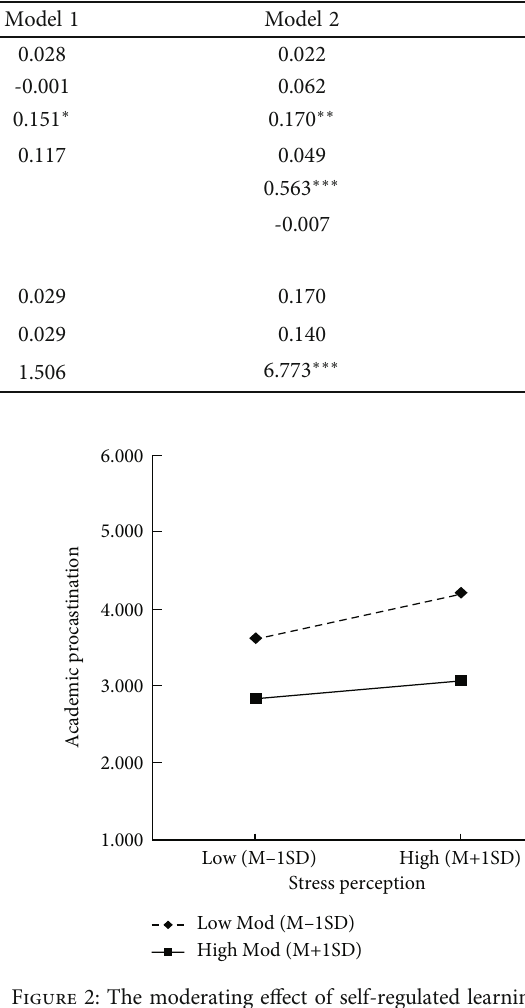
Table 4: Strati fi ed regression results.